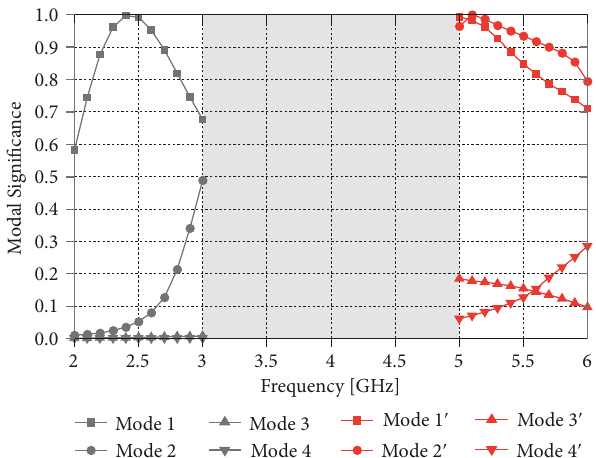
Figure 3: MS for the dominant CMs of the MIMO antenna#1 without the